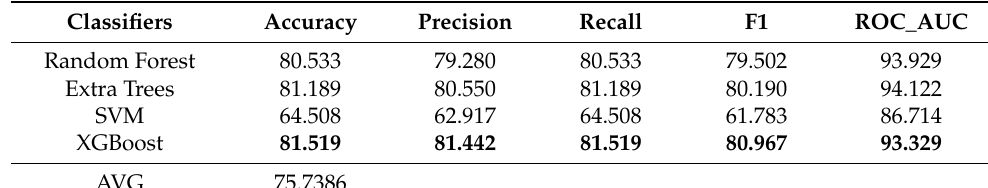
Table 13. Experimental Results using S2HT2 with 2388 features.